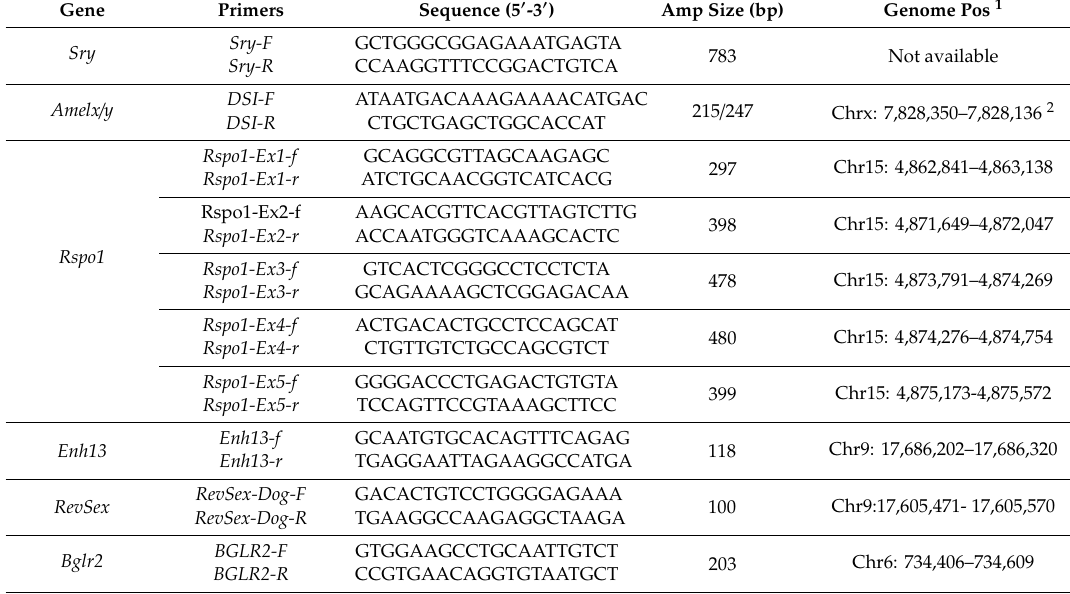
Table 1. Primers used in PCR and